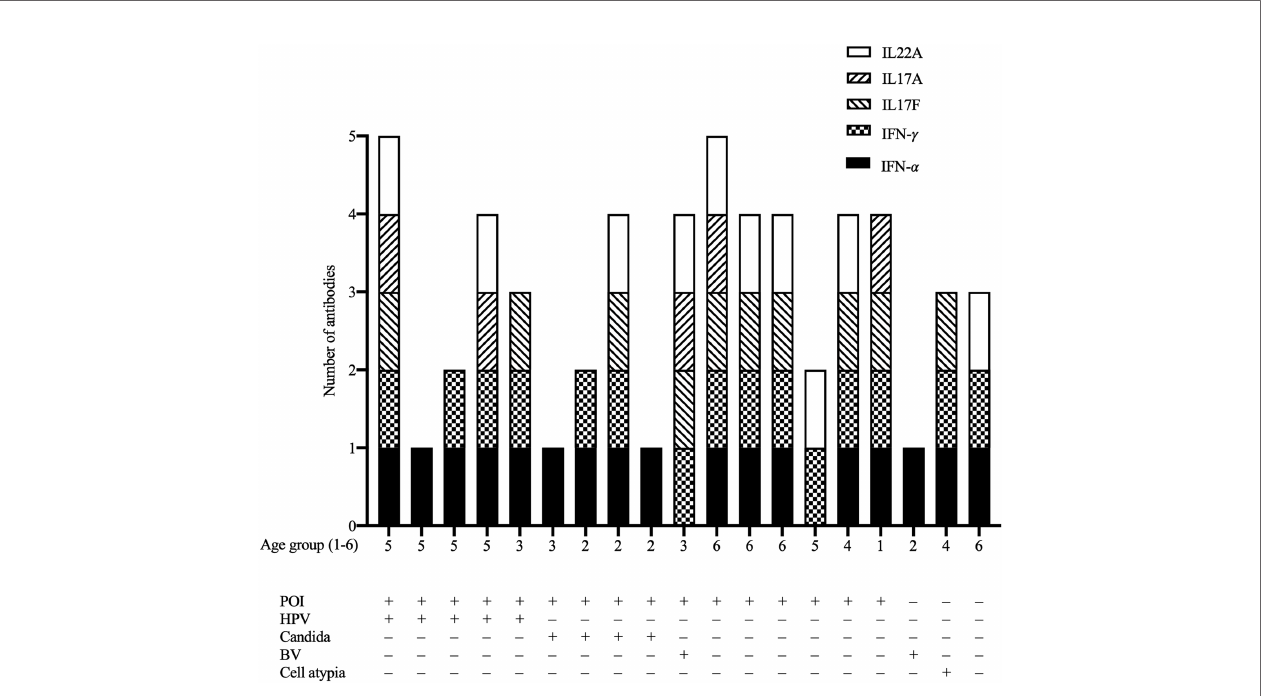
FIGURE 2 | The number of positive anti-cytokine autoantibodies (IFN- a , IFN- g , IL17A, IL17F, IL22) in the 19 female patients with APECED in relation to age group, premature ovarian insuf fi ciency (POI), human papillomavirus infection (HPV), candidiasis (CMC), bacterial vaginosis (BV), and cervical cell atypia. Age groups: 1,